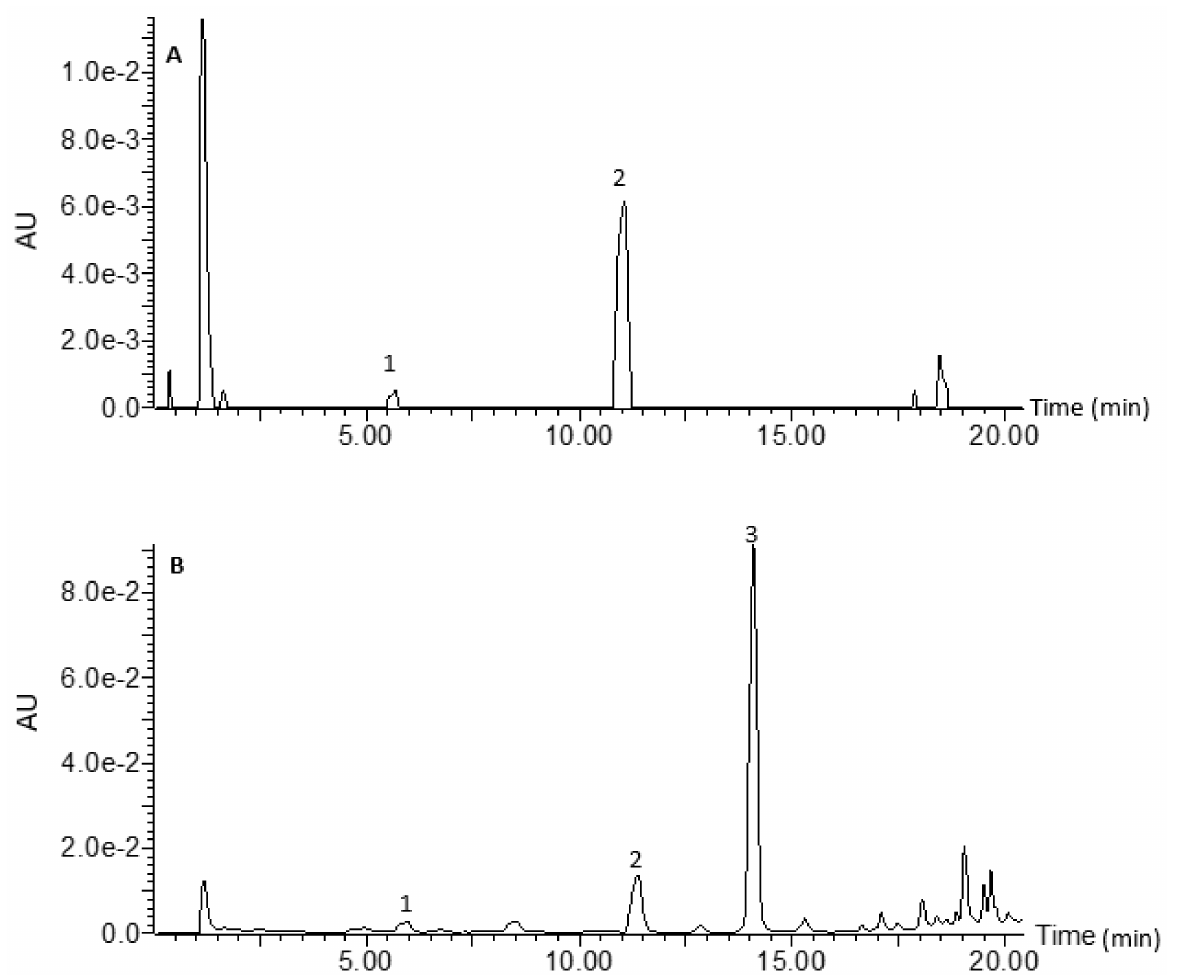
Figure 1. Liquid chromatogram for raw rice at 280 ( A ) nm and 350 nm ( B ). Key: 1 = p -hydroxybenzaldehyde; 2 = p -coumaric acid; 3 = ferulic